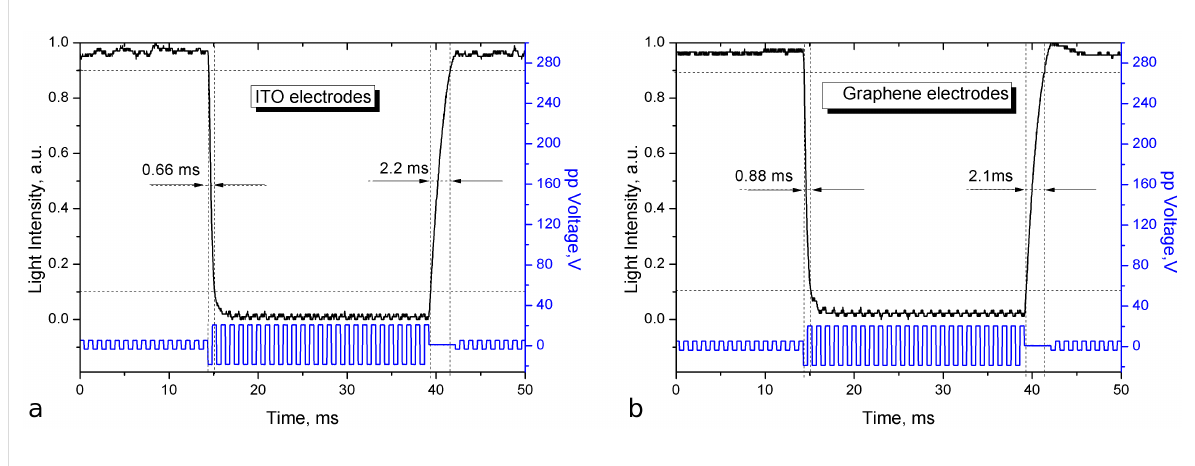
Figure 7: Time characteristic of liquid crystal cells with ITO (a) and graphene (b) transparent conductive layers operating as a light valve in the fast switching mode.